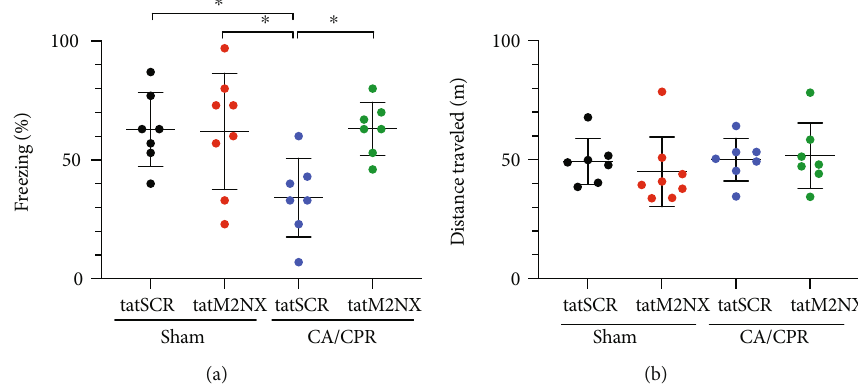
Figure 4: Delayed inhibition of TRPM2 restores memory function. (a) Quanti fi cation of freezing behavior 24 hours after contextual fear conditioning in a novel environment in mice administered 20mg/kg tatSCR (black) or 20 mg/kg tatM2NX (red) after sham surgery or mice administered 20 mg/kg tatSCR (blue) or 20mg/kg tatM2NX (green) 13 days after recovery from CA/CPR and behavior testing initiated on day 14 after CA/CPR. (b) Quanti fi cation of distance traveled in the same mice as in (a) in open fi eld testing, indicating no changes in locomotion to account for di ff erences in freezing. Each point represents 1 mouse, and ∗ p < 0 : 05 by one-way